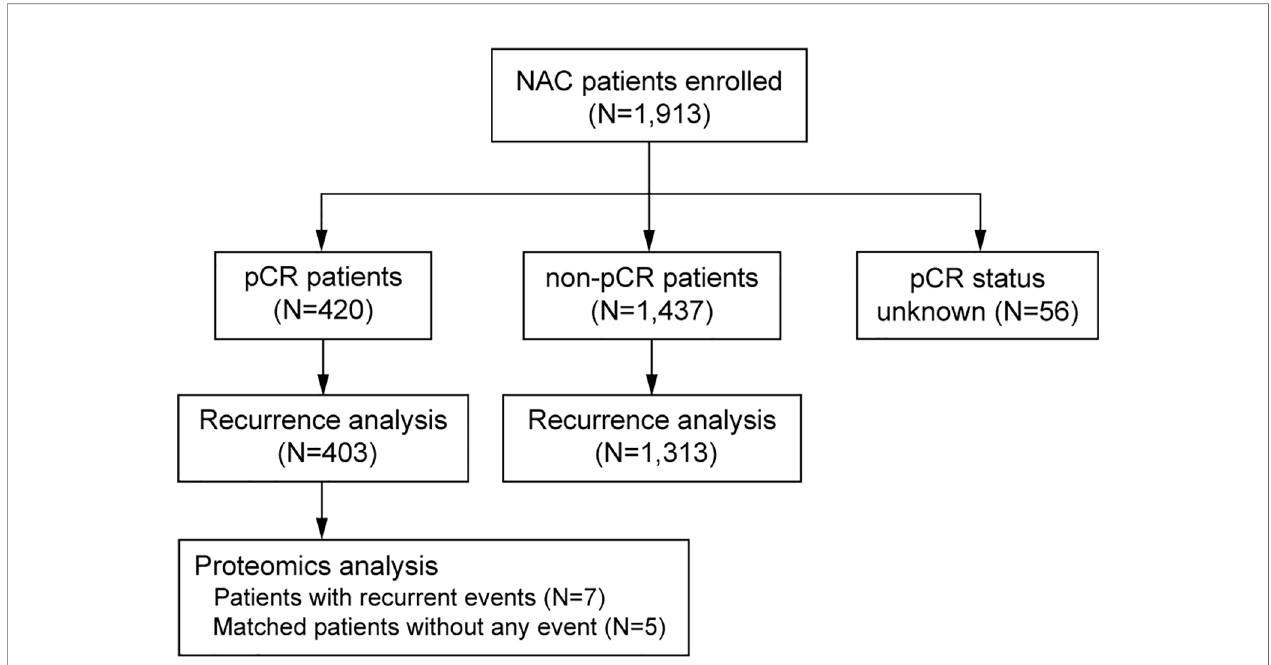
FIGURE 1 | CONSORT diagram of the studied patients, number of patients with different pCR status, number of patients for survival analysis and number of patients for proteomics analysis. pCR, pathologic complete